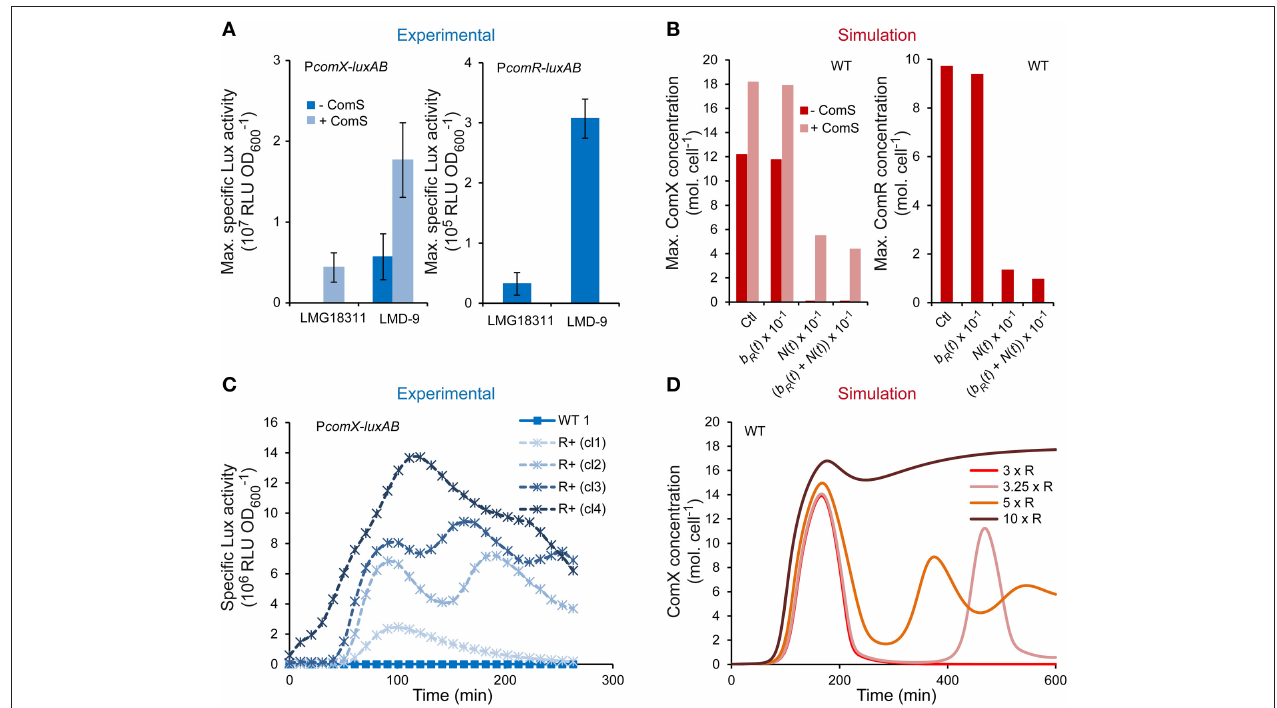
FIGURE 6 | Role of ComR abundance on the competence level of S. thermophilus LMG18311. (A) Maximum specific luciferase activity driven by promoters P comX (left panel) and P comR (right panel) in respective reporter strains CB009 and LF146 grown in CDML. The symbols ( indicate that no ComS 17 - 24 and 1 µ M ComS 17 - 24 was added 1h after inoculation. The values are means from triplicate experiments (SEM). (B) Maximum concentrations [molecules (mol.) cell − 1 ] of ComX (left panel) and ComR (right panel) computed by integrating the system with parameters values N ( t ) of system S1 (Ctl) (see Table 2 ), with a 10-fold lower ComR basal production rate ( b R ( t ) of ComR production rate, i.e., b R ( t ) + ComR activation rate ( N ( t ) 10 − 1 ) and with a 10-fold lower total ComR production rate (( b R ( t ) + N ( t )) × condition of ComS ext equal to zero (- ComS) or equal to 150 mol. cell − 1 (+ ComS). (C) Kinetics of specific luciferase activity (RLU OD − 1 600 ) by representative clones (cl1, cl2, cl3, and cl4) of the LMG18311 derivative reporter strains CB009 (P comX - luxAB ) containing an empty plasmid (CB009 [ pMG36eT ] ; WT) or the constitutive comR overexpression vector (CB009 [ pMGcomRstrep ] ; ComR + ). (D) Consequences of increasing the maximum ComR basal production rate by a 3 (3